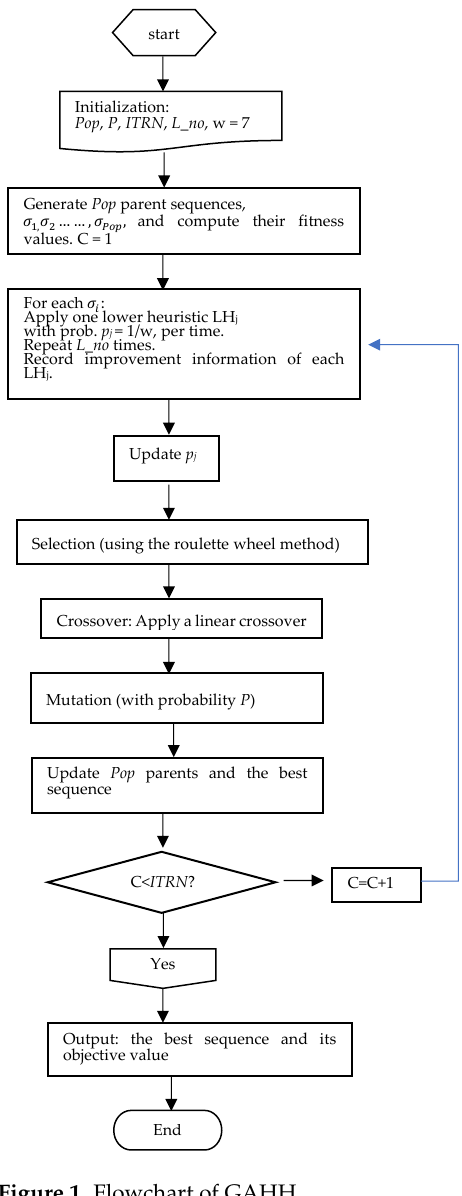
Figure 1. Flowchart of GAHH.